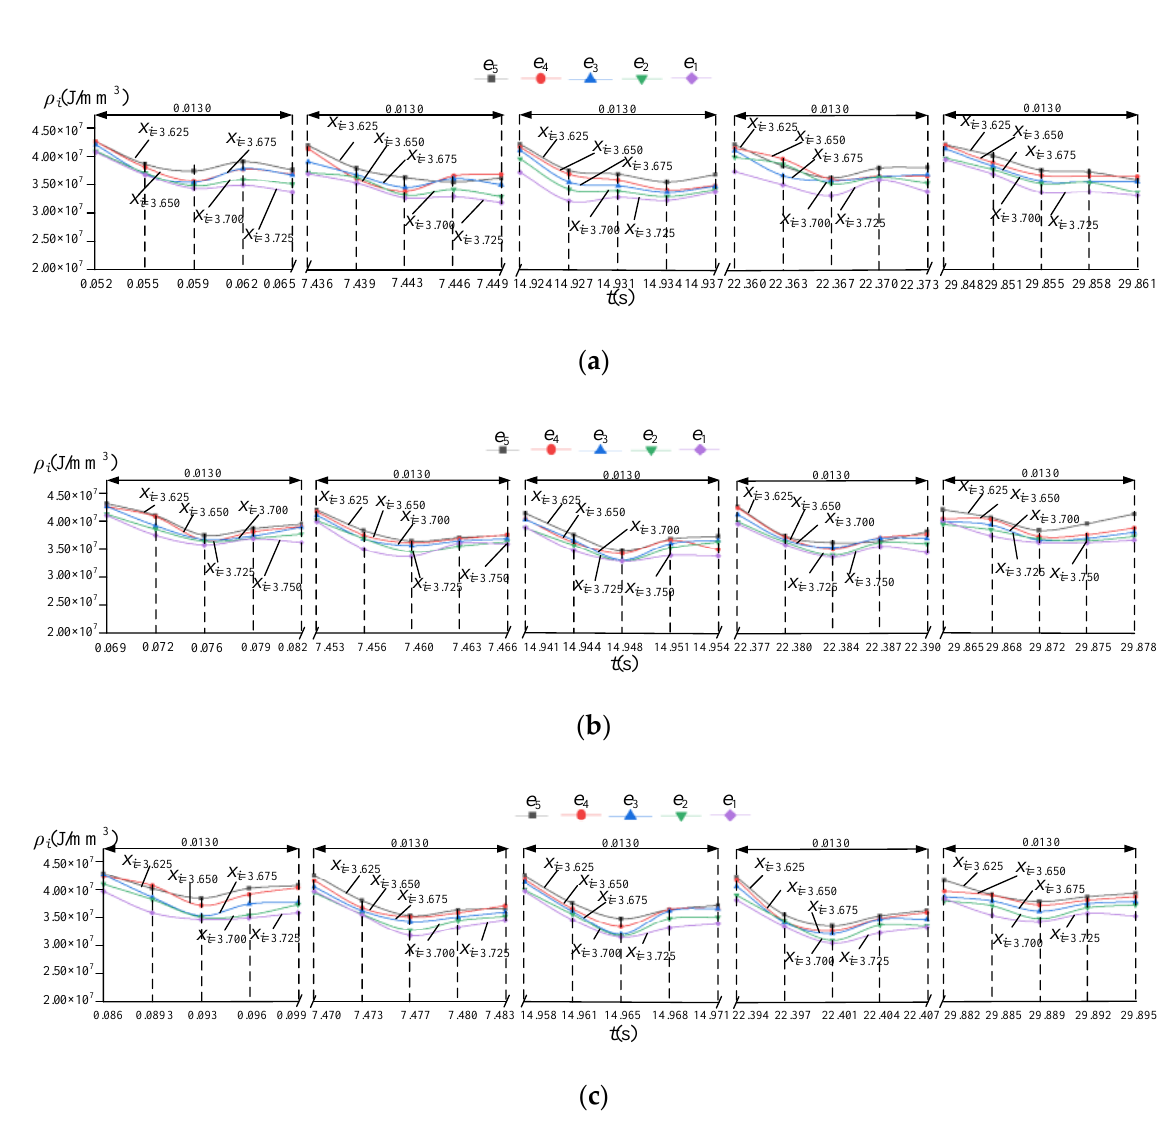
Figure 7. Instantaneous friction wear energy density on the tool flank of scheme 1 ( y i = 6.700 mm): ( a ) tooth 1; ( b ) tooth 2; ( c ) tooth 3.